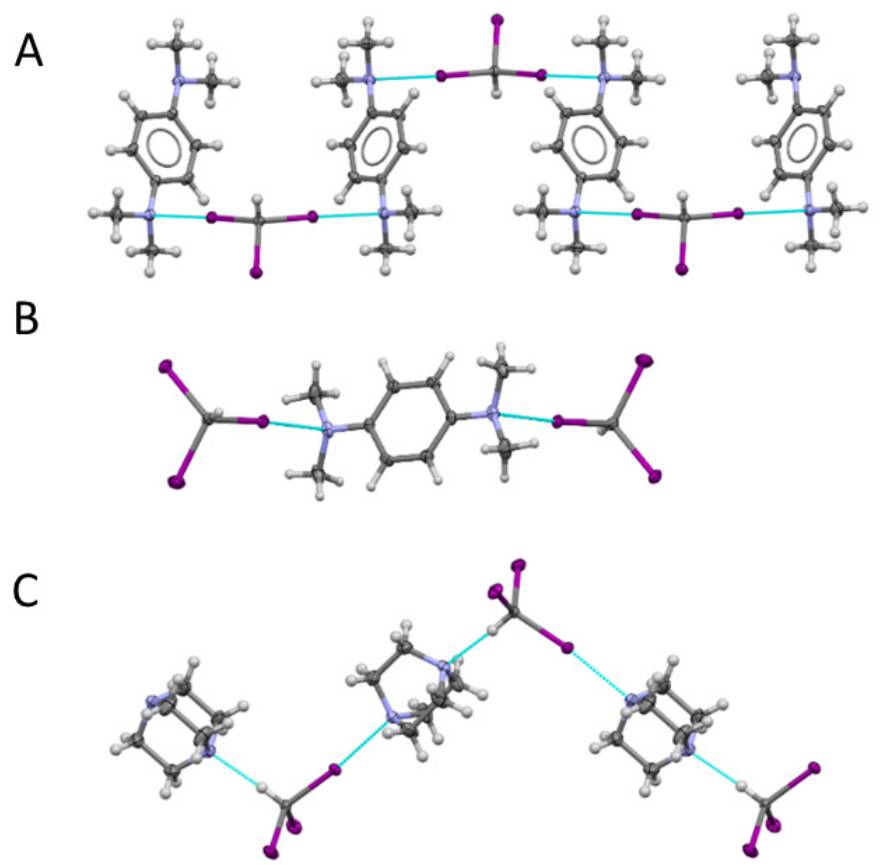
Figure 4. X-ray structures of co-crystals of iodoform with TMPD (( A ): 1:1, ( B ): 2:1) and DABCO ( C ) showing alternating halogen (and hydrogen)-bonded zigzag chains or discrete 1:2 complexes. Chains of TMPD with iodoform in their 1:1 co-crystals were formed by I–N halogen bonding between these molecules involving two iodine substituents of each CHI 3 and two amino groups of each TMPD. The I–N distances of 2.902 Å were about 22% shorter